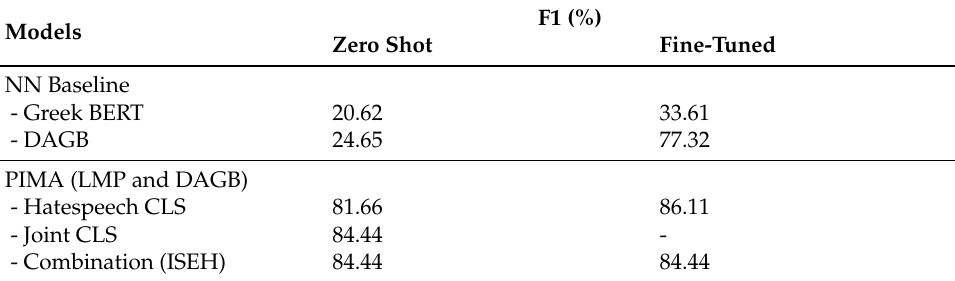
Table 8. Evaluation of our best models on OGTD dataset